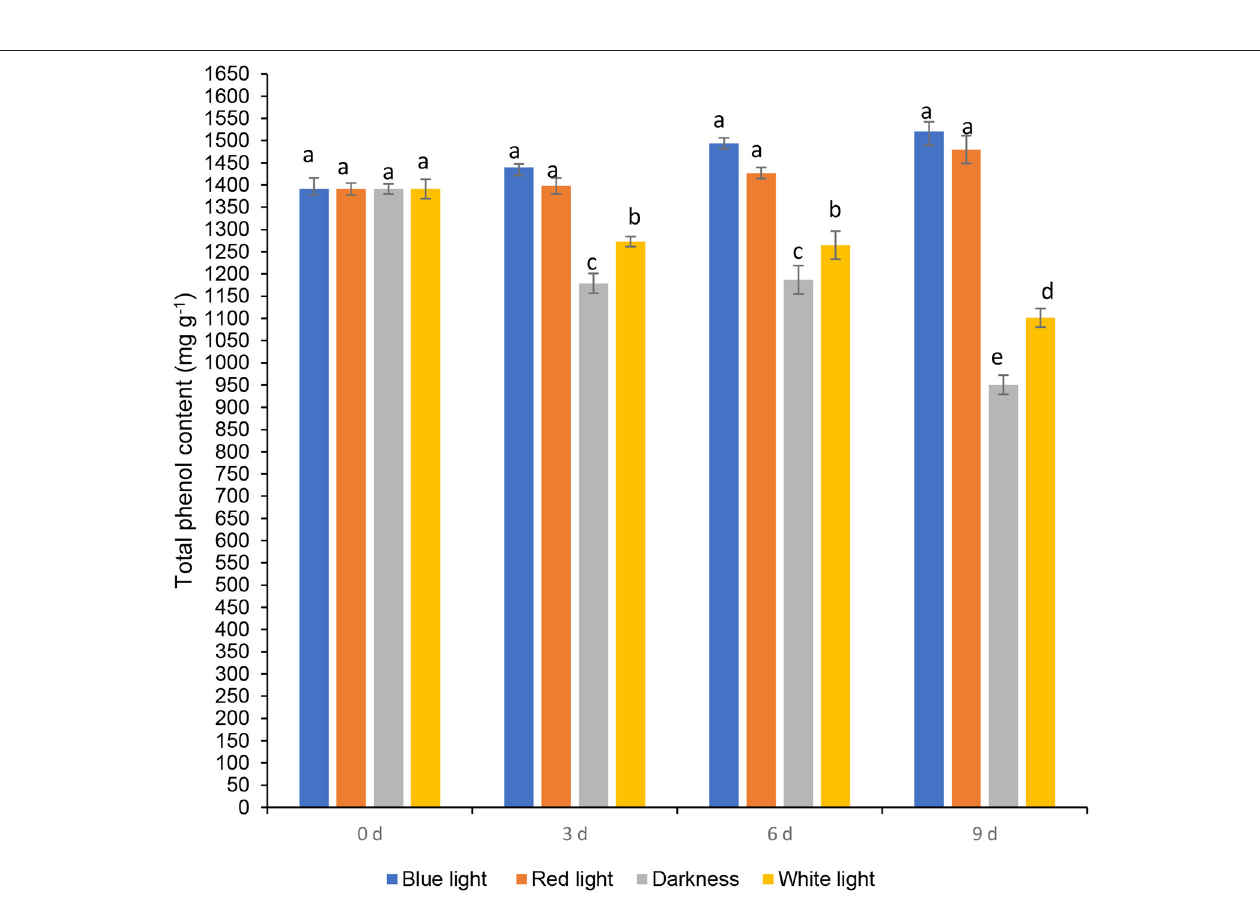
FIGURE 5 | Effect of blue and red LED light treatment on β -carotene content coriander ( Coriandrum sativum ) leaves. Different letters in the same bar indicate significant differences at p < 0.05.